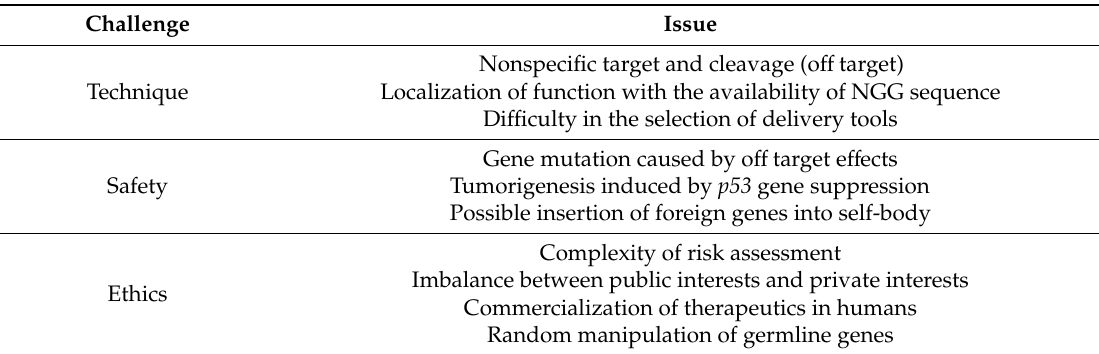
Table 2. Challenges of medical treatment for opioid